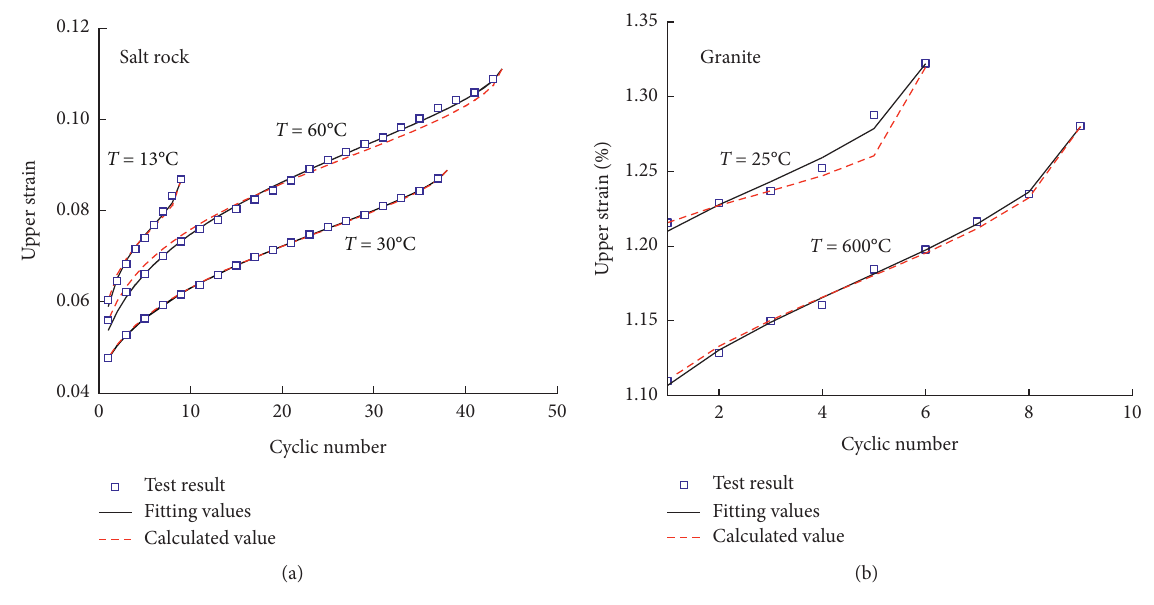
Figure 7: Upper strain of rock fatigue. Table 2: Fatigue damage model parameter